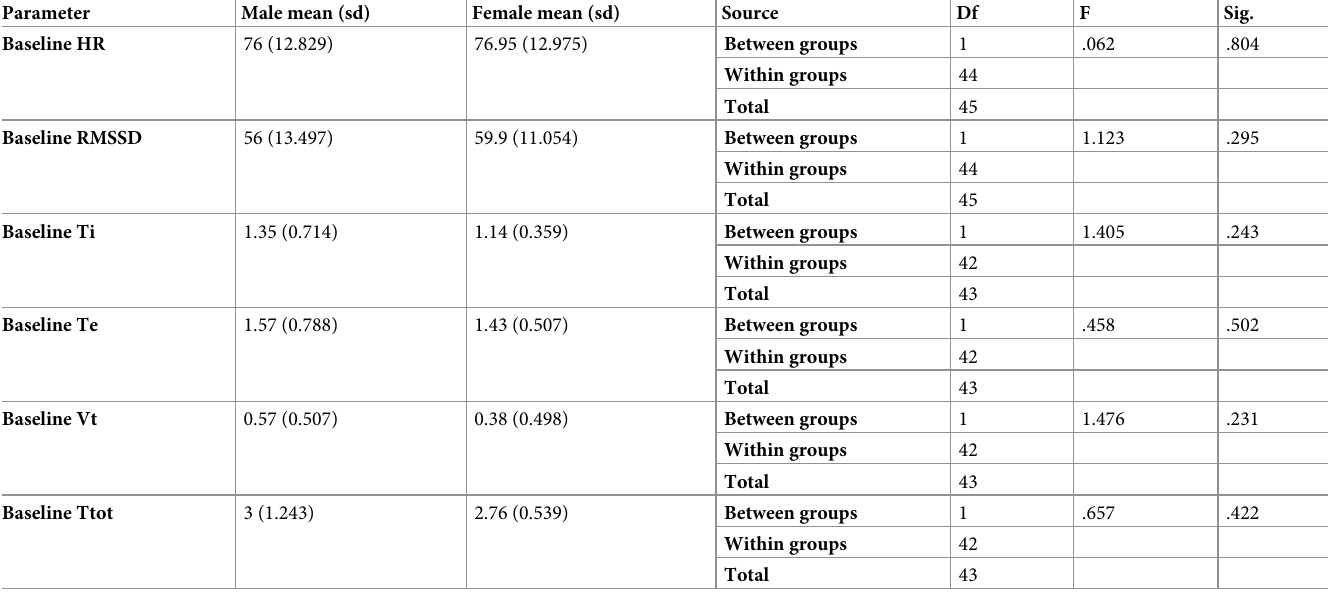
Table 3. ANOVA for baseline cardiac and respiratory responses of males and